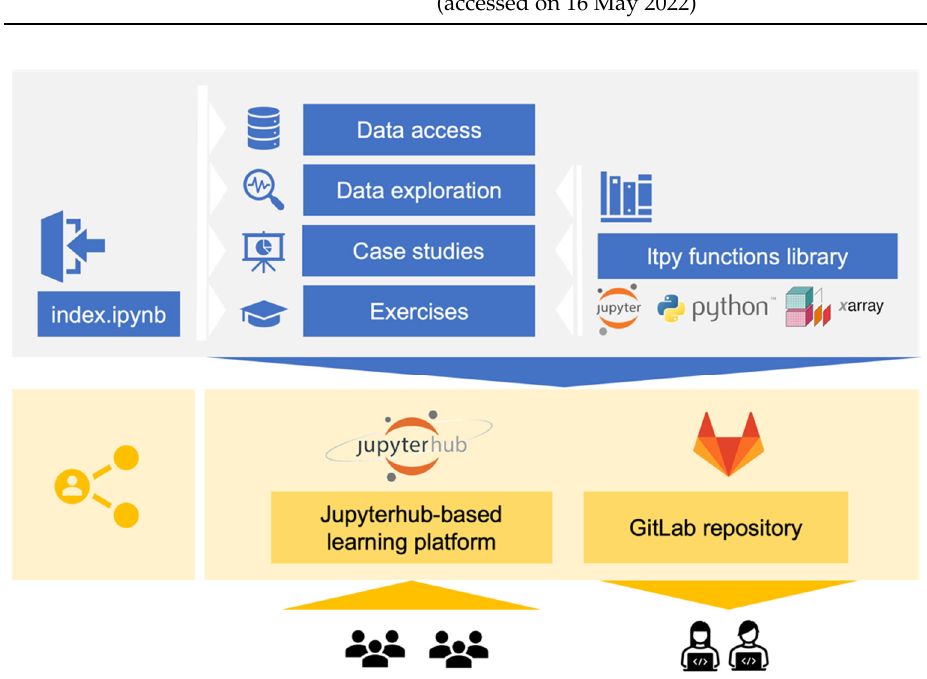
Figure 1. Overview of Learning Tool for Python main course: general course outline (blue) and the modalities of access (yellow). The notebooks are organized in notebooks on data access, data exploration, case studies and exercises. Learners can either clone the content onto their local machines from a publicly accessible GitLab repository or directly access the JupyterHub-based training platform under https://ltpy.adamplatform.eu (accessed on 16 May 2022). The course starts with the index.ipynb notebook, which introduces learners to the course outline and modality. A notebook with 14 pre-defined functions helps to modularize code and to cater for different levels in programming and